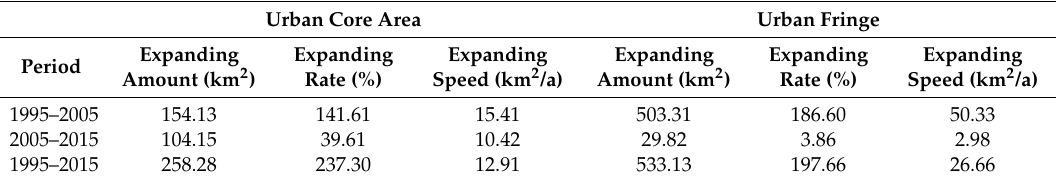
Table 4. Quantitative status of the expansion in the urban fringe of Changchun (1995–2015).